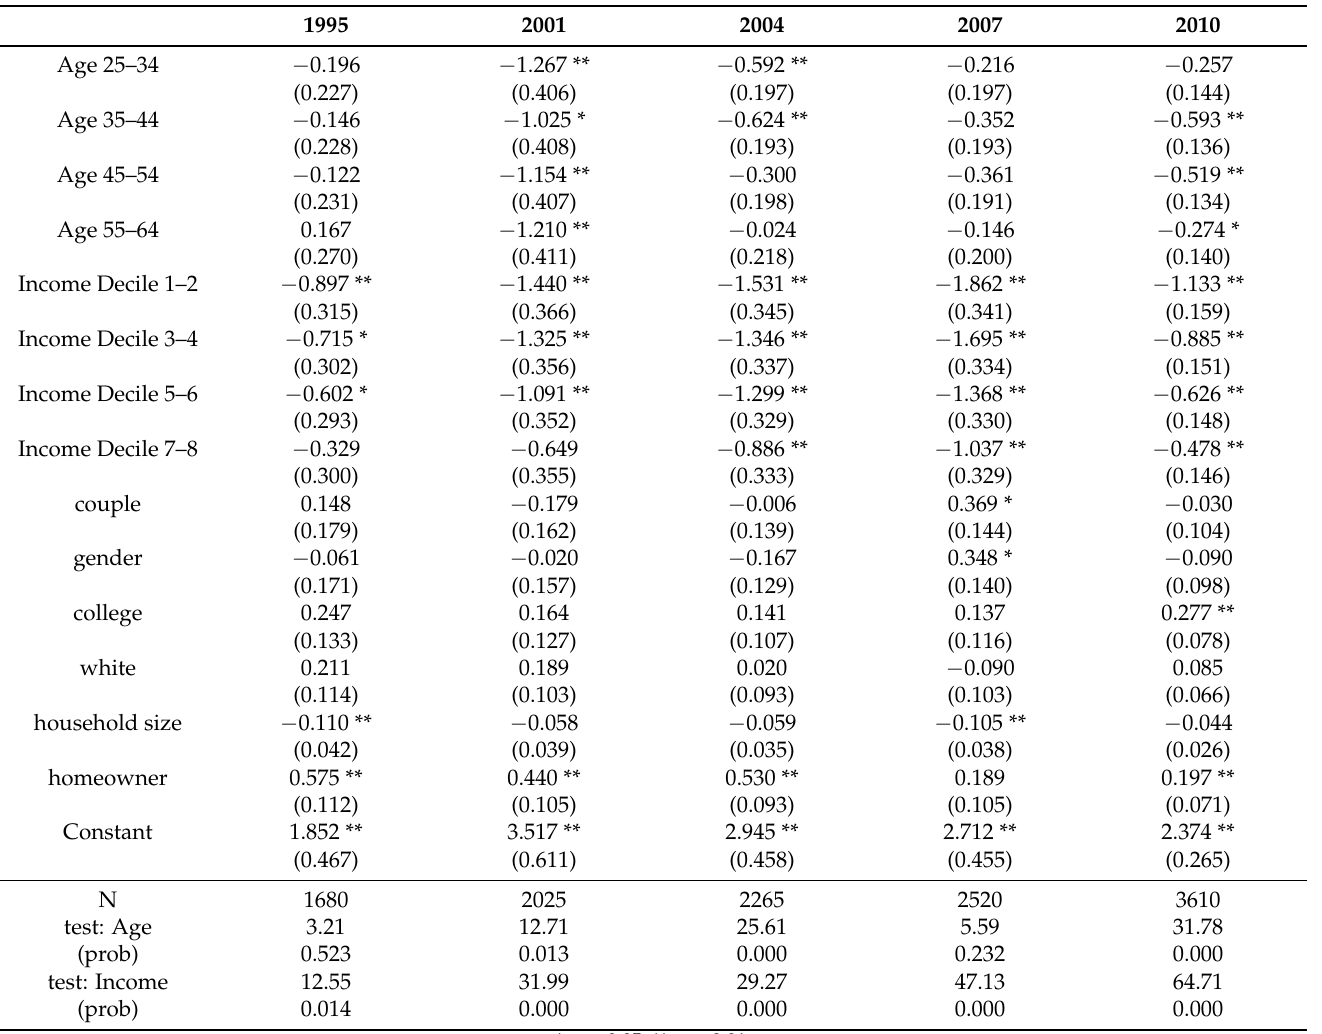
Table A1. Probability of Repaying Among